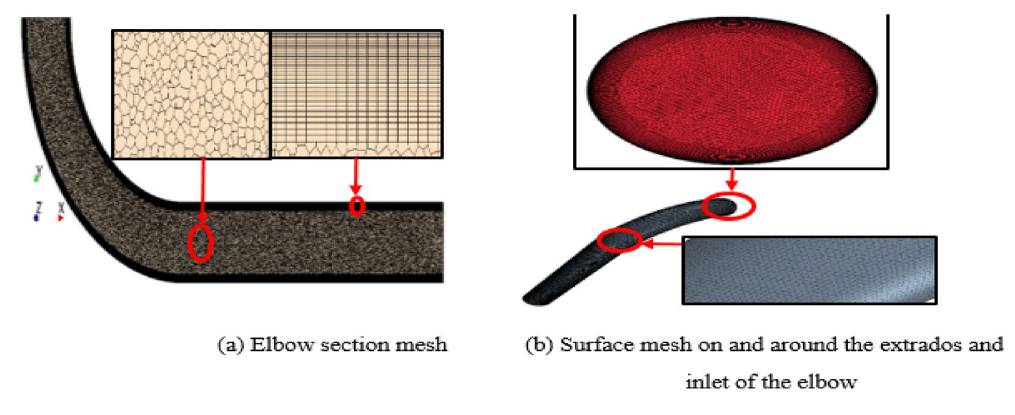
Figure 8. Mesh of elbows model.